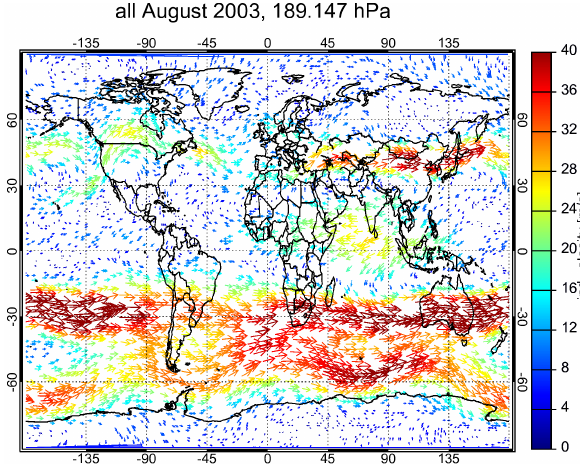
hemispheric difference between the higher volume mixing ratios (VMRs) in the NH compared to lower VMRs in the Southern Hemisphere (SH) at both 277 hPa and 185 hPa. At 277hPa, the highest average acetone VMRs are found over Fig. 8. Monthly-average wind field for August 2003 derived from Greenland and Western Siberia (between 1.6 and 2.3 ppbv) Fig. 8. Monthly-average wind field for August 2003 derived from ECMWF data. Data are taken on level 29 (187hPa). Each wind ECMWF data. Data are taken on level 29 (187 hPa). Each wind vector is coloured according to average wind vector is coloured according to average wind velocity.